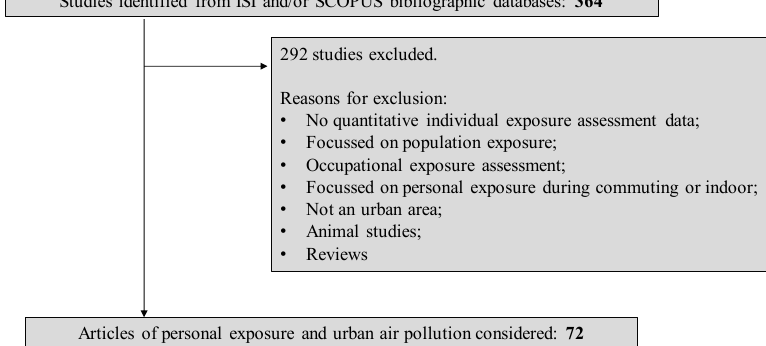
Figure 3. Summary of the article selection process.